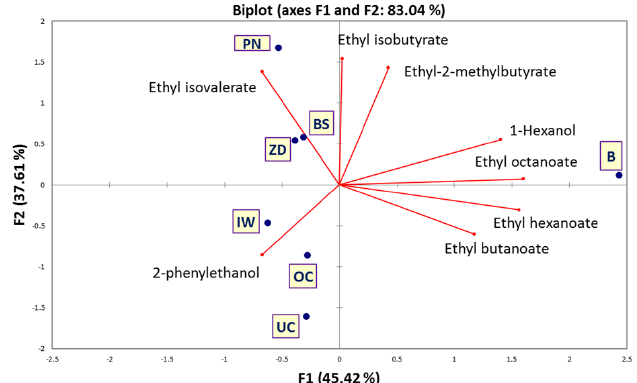
Figure 2. Principal Components Analysis (PCA) of the volatile aroma compounds (VOCs) in wines analysed at 15 weeks post-disgorging. NV sparkling wine without sugar addition = zero dosage (ZD), NV sparkling wine + sugar (BS), unoaked still Chardonnay wine + sugar (UC), Pinot noir 2009 sparkling wine + sugar (PN), Brandy + sugar (B), Icewine (IW) + sugar and oaked still Chardonnay wine + sugar (OC).